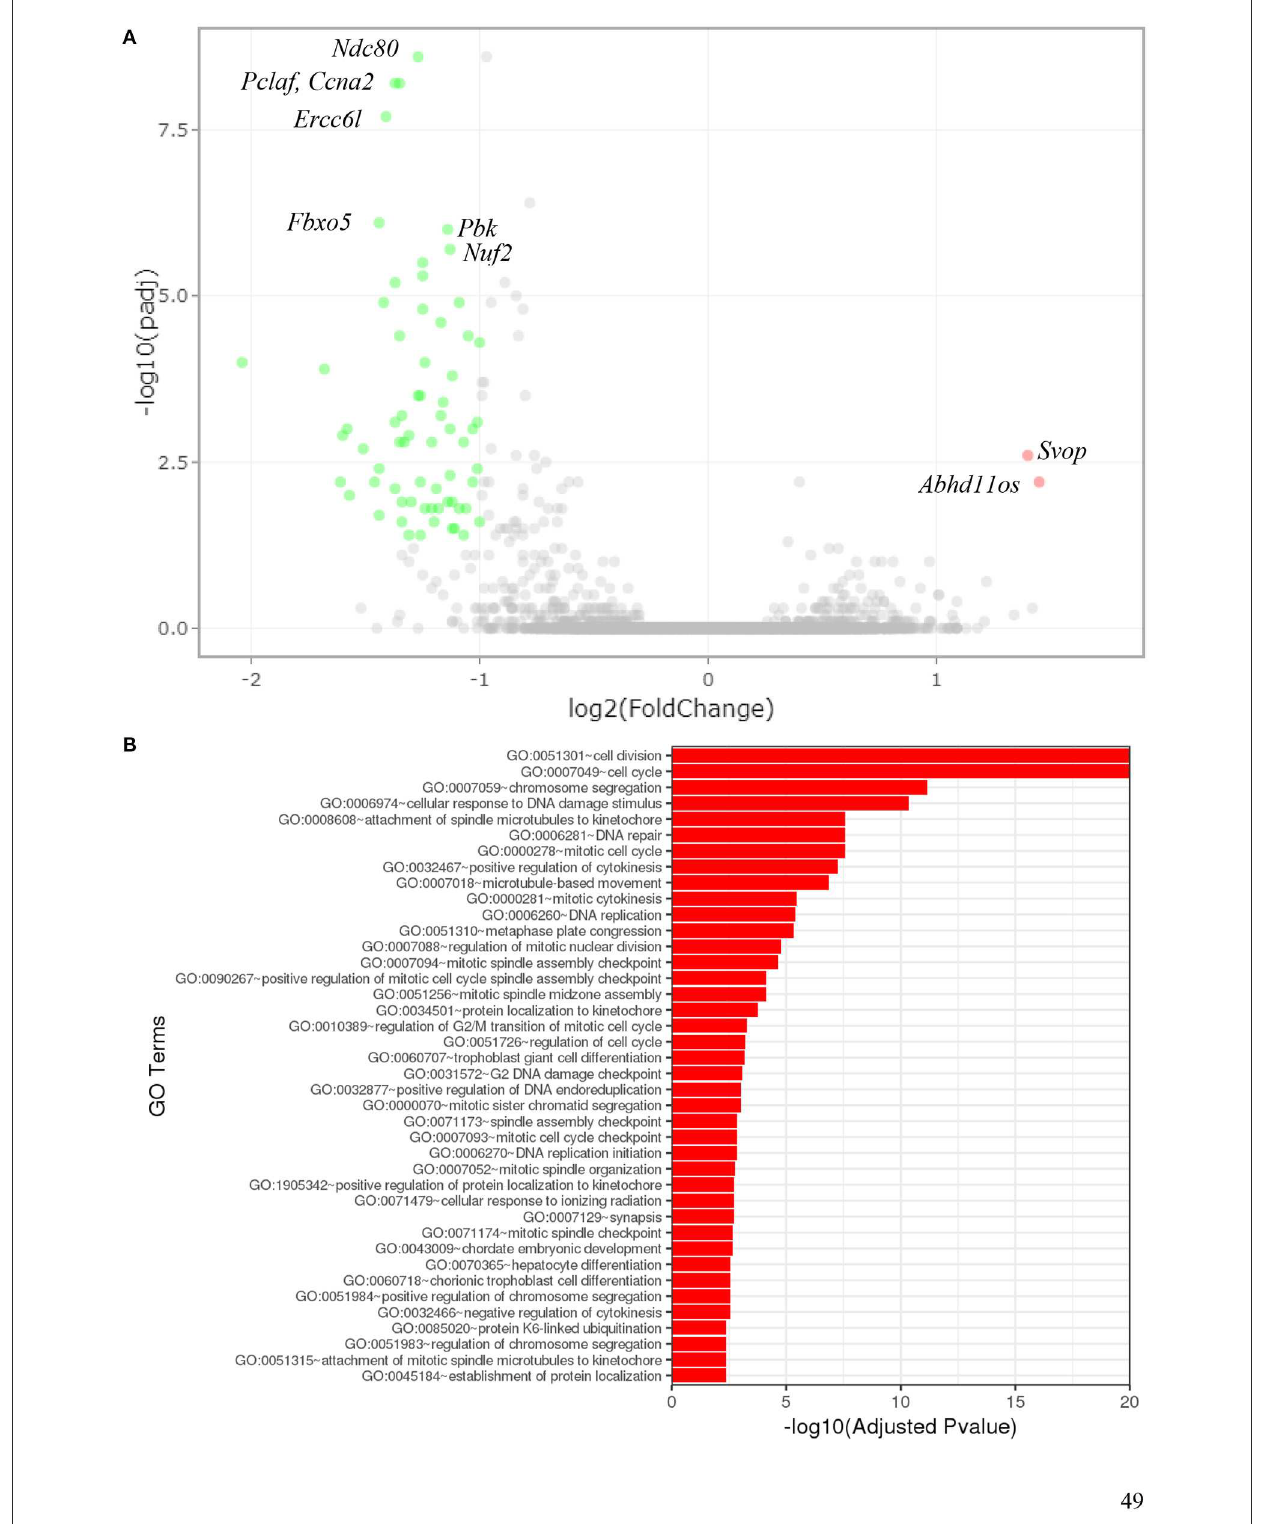
FIGURE11 Gene expression of astrocytes 24h after exposure to 2Gy X-rays. Gene expression of primary murine astrocytes was analyzed using RNA sequencing ( n = 4). (A) In this volcano plot, the log 10 of the adjusted P -value [log 10 (padj)] is plotted against the log 2 Fold Change in expression of each gene. The two upregulated genes (pink dots) are annotated as well as some of the most significantly downregulated genes (green dots). (B) Gene ontology (GO) terms that were significantly enriched with an adjusted P -value < 0.05 in the differentially expressed gene sets are listed (up to 40 terms). The full list of enriched GO terms is available in Supplementary